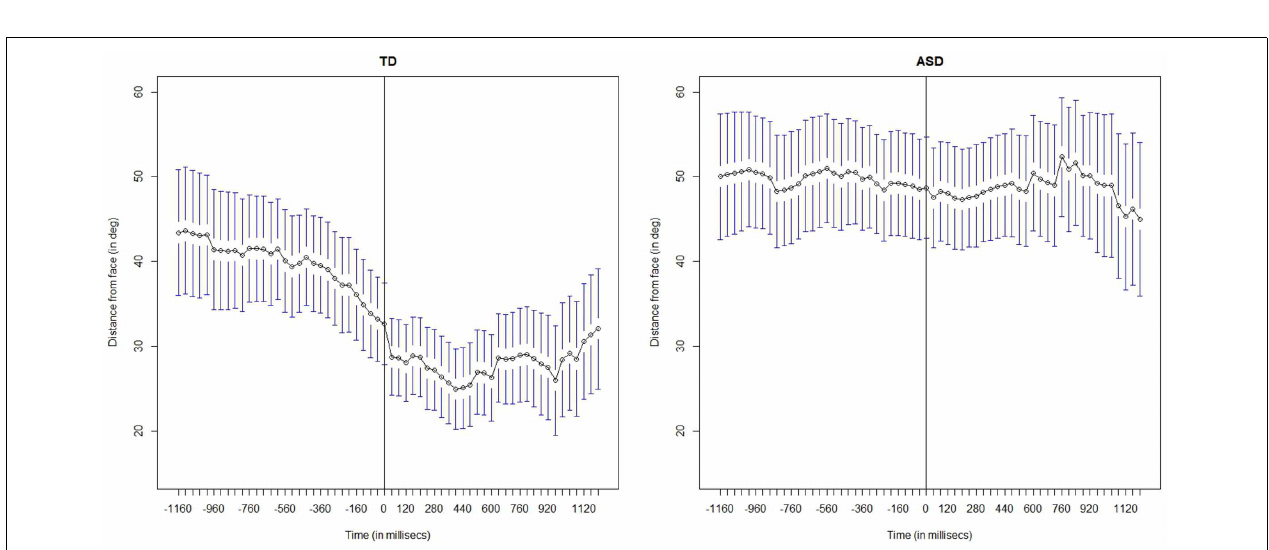
patterns are depicted for each frame, 1200s (30 frames) before and after the adult’s onset of the speech. The vertical line in the middle highlight the onset of the social